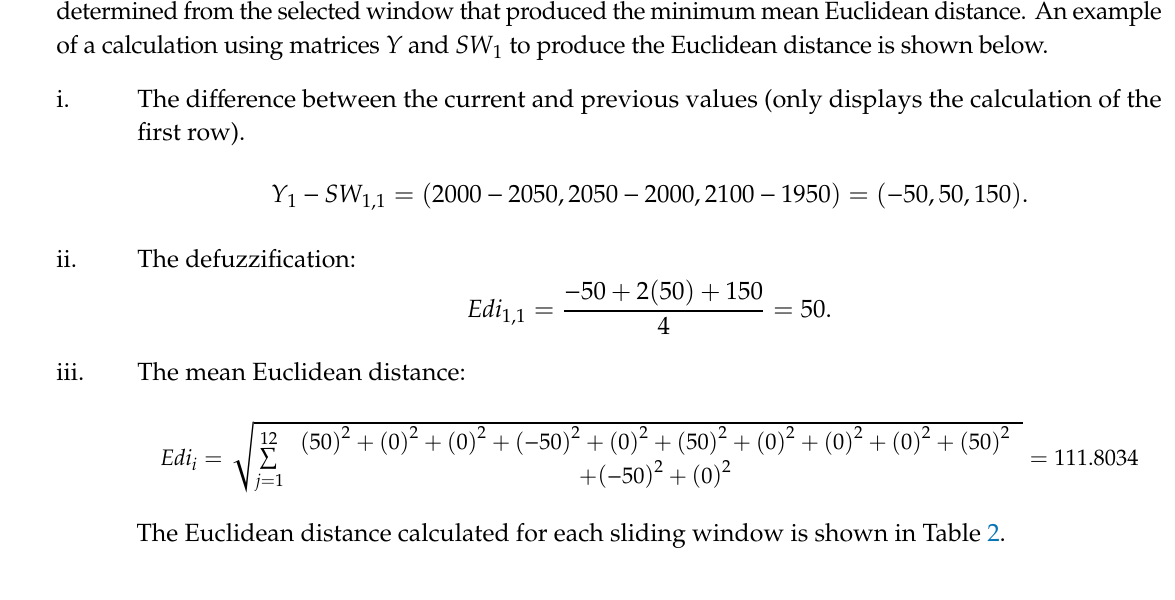
Table 2. Mean of Euclidean distance for the twelve sliding windows, SW i